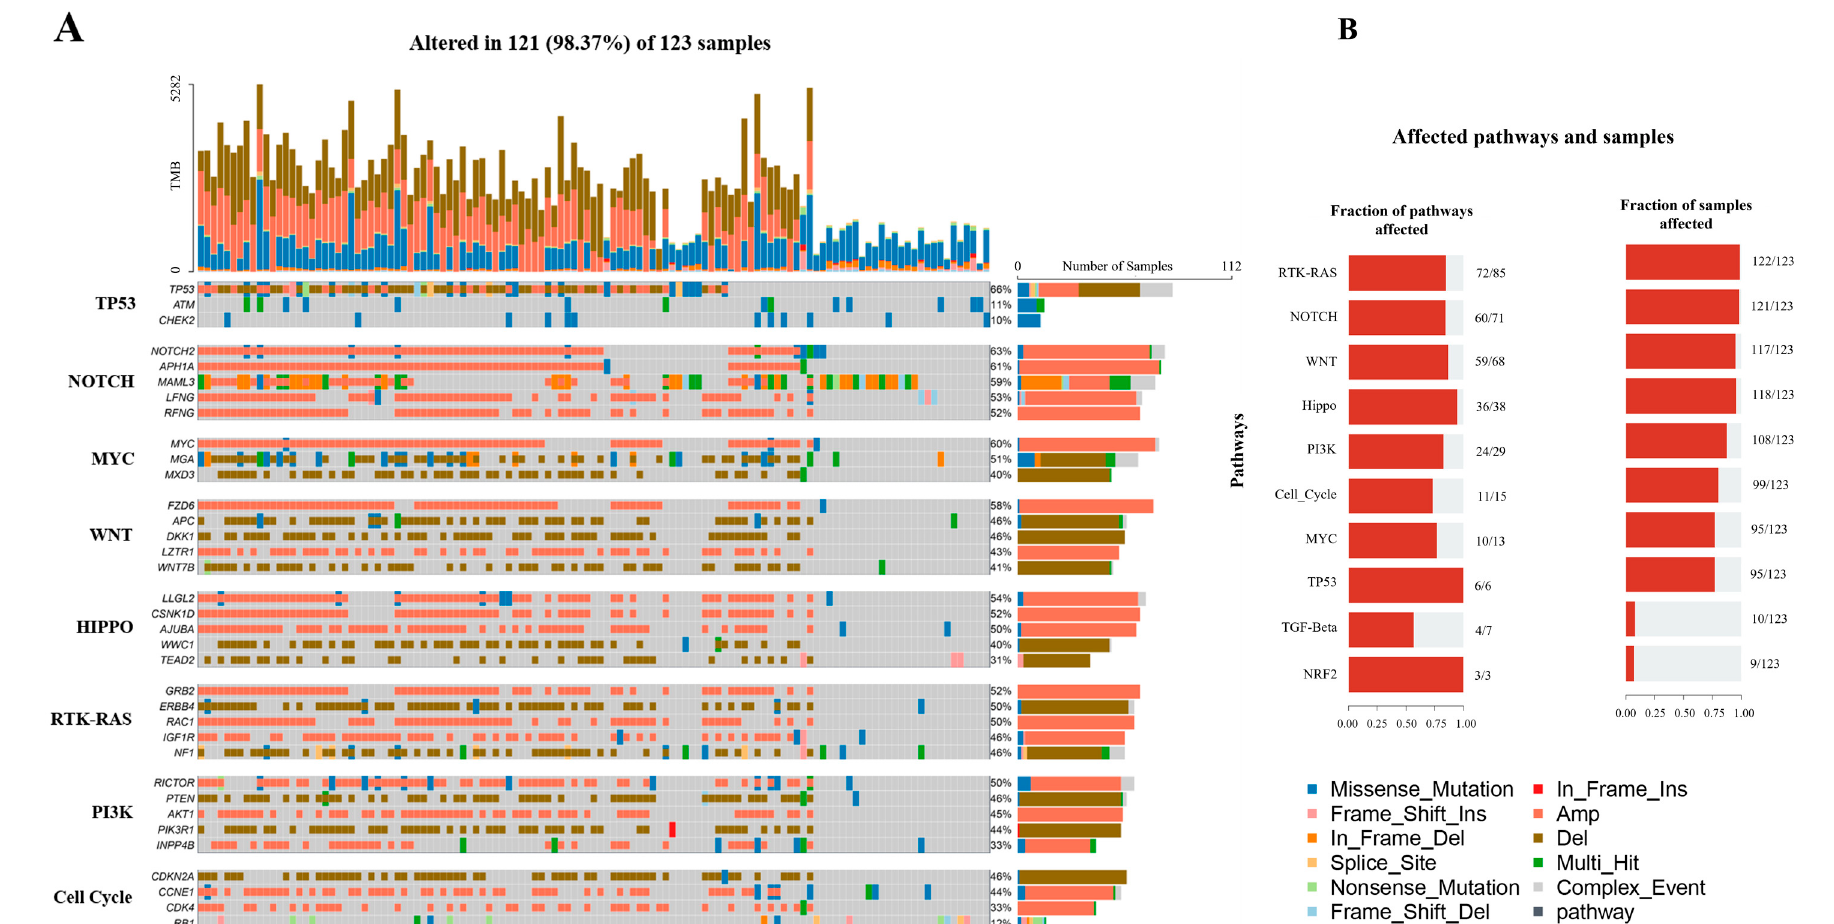
Figure 1. ( A ) Oncoplot showing the top 5 altered genes with more than 10% samples containing mutations in the TCGA enriched pathways. The fraction and the number of samples with variations in the corresponding genes are shown on the right as percentages and the bar plots ( B ) Enriched oncogenic pathways showing the fraction of genes and samples a ff ected.